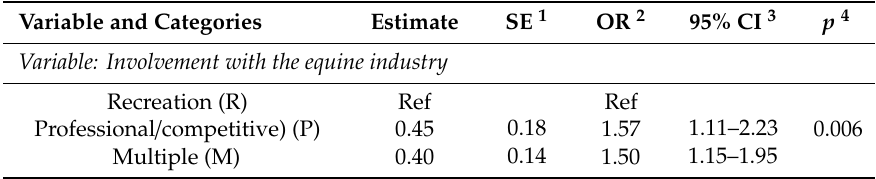
Table 7. Results of multivariate logistic regression analysis of associations between reporting an incident and the explanatory variables: involvement with the equine industry, driver identity and reason for